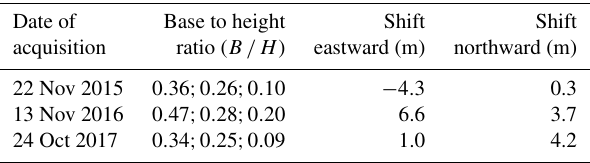
Table 3. Characteristics and IDs of the Pléiades images. Horizontal shifts relative to the UAV orthoimages are also given. Each base-to- height ratio corresponds to a stereo